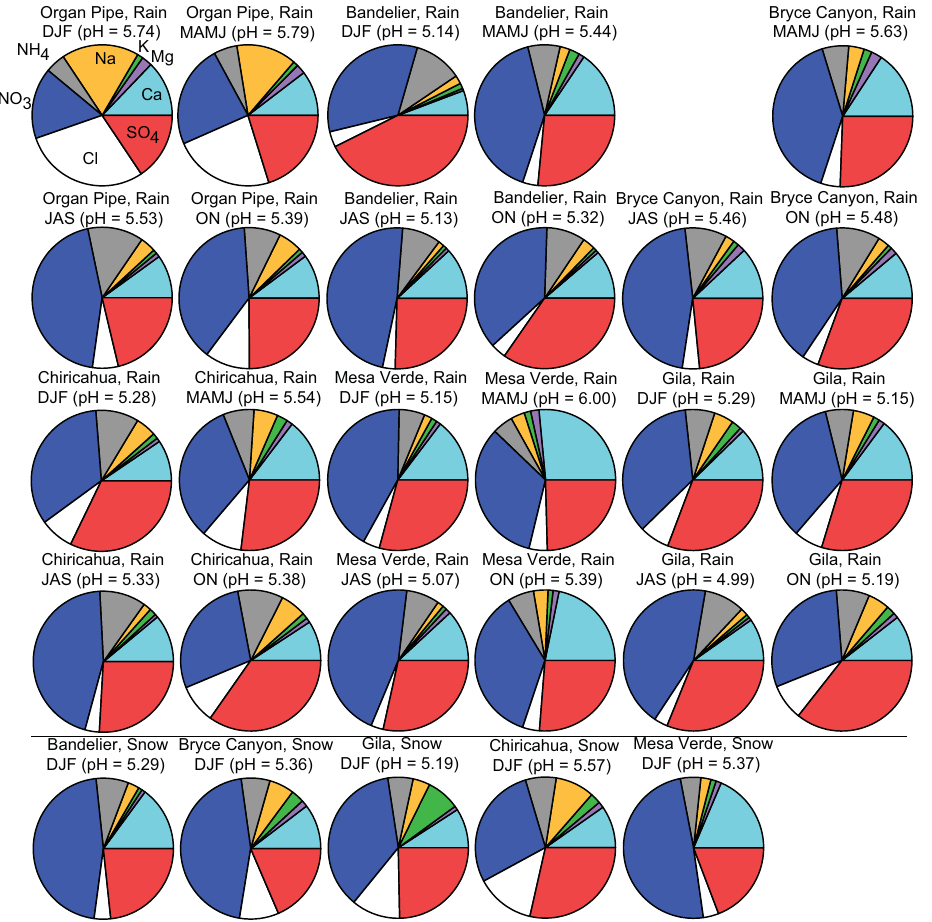
Fig. 9. (Top four rows) Summary of pH and chemical mass fraction data for rain during different periods of the year. (Bottom row) Snow pH and chemical mass fraction data for DJF, which is the season with the most snow data available. The labels in the top left pie are the same for the other pies. Note that during DJF there is no rain data for Bryce Canyon or snow data for Organ